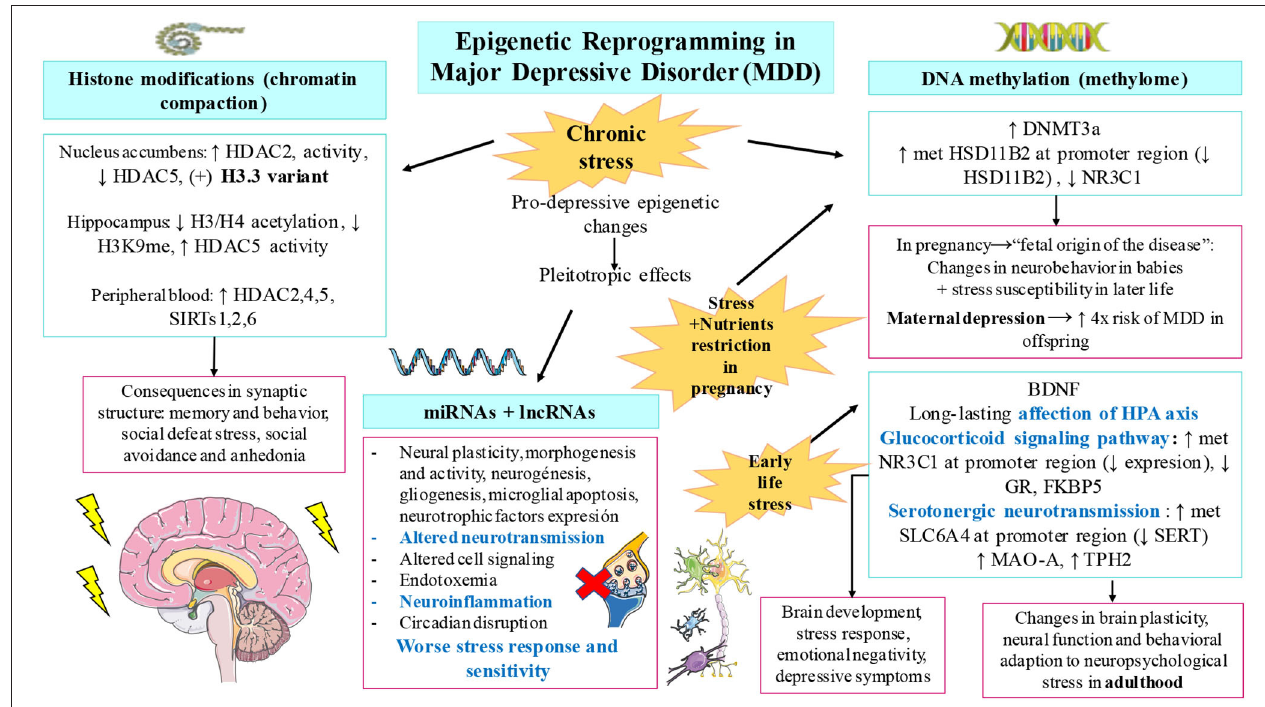
FIGURE 1 | Compiled evidence related to epigenetic changes involved in major depressive disorder (MDD). As shown, chronic stress, early-life stress, and prenatal stress accompanied with nutrient restriction are pivotal drivers of the epigenetic modifications observed in patients with MDD. These changes include histone modifications, altered DNA methylation patterns, and the dysregulation of non-coding RNAs including microRNAs (miRNAs) and long non-coding RNA (lnRNA). Some of the most relevant findings collected in this manuscript for each modification are summarized. These variations lead to important alterations in the brain